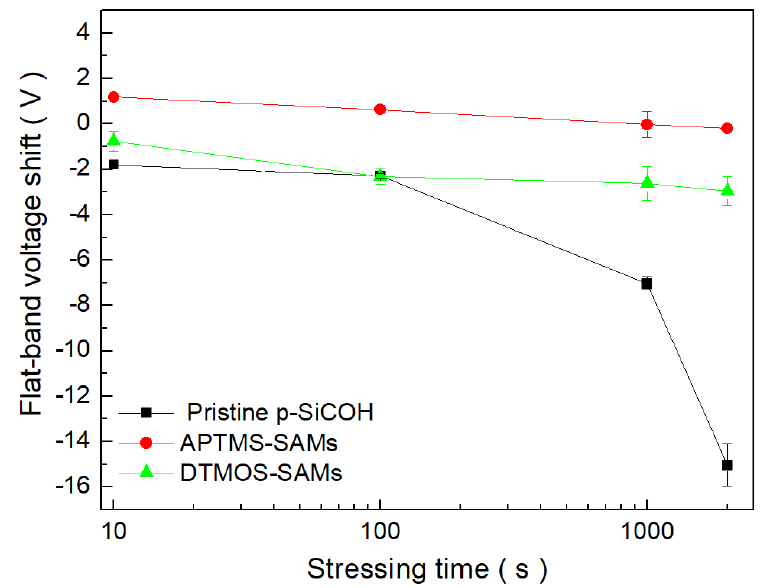
Figure 7. Flatband voltage shifts of pristine, APTMS-SAMs and DTMOS-SAMs p-SiOCH films after electric stress at 5 MV/cm with varying intervals.